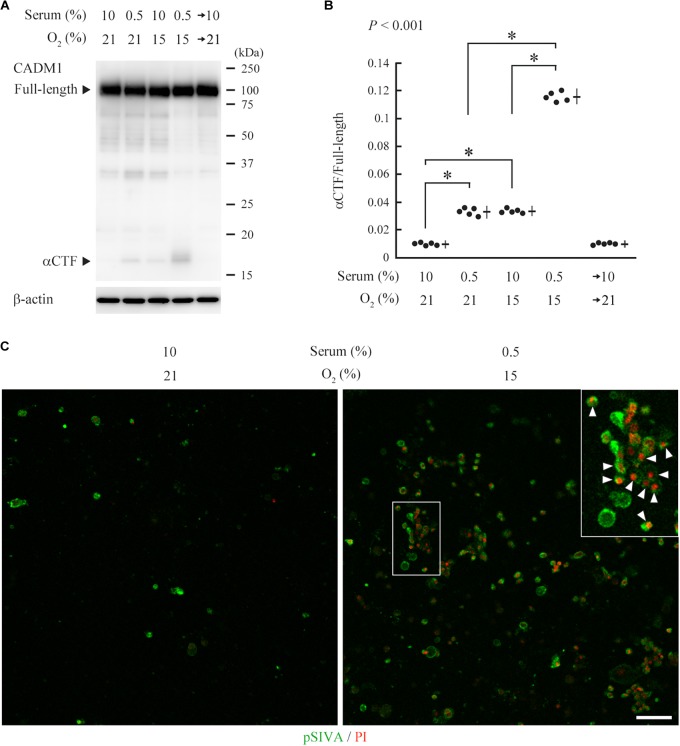
Induction of urinary cell adhesion molecule 1 (CADM1) ectodomain shedding and apoptosis in CNT renal tubular cells under ischemia-like conditions. (A) CNT cells were cultured for 3 days under normal conditions [10% fetal calf serum and 21% O2] or ischemia-like hypoxic conditions [10% serum and 15% O2, serum-starved (0.5% serum and 21% O2)], or both (0.5% serum and 15% O2). The combined condition was restored to normal, and the cell culture was continued for another 2 days (serum→10% and O2→21%). Cell lysates were analyzed by Western blotting with anti-CADM1 C-terminus antibody (upper panel). The blot was reprobed with an anti-β-actin antibody to indicate the amount of protein loading per lane (lower panel). Representative results are shown. (B) Expression levels were densitometrically measured from five independent experiments and were plotted. The mean ratios of αCTF/full-length CADM1 and the SDs are depicted as cross lines. P-value using one-way ANOVA is shown, and the Bonferroni correction was applied to particular two groups: ∗P < 0.01. (C) CNT cells were cultured for 3 days under normal or ischemia-like conditions as indicated, and were then labeled with pSIVA (green) and propidium iodide (PI; red). A boxed area is enlarged in the inset. Arrowheads indicate pSIVA and PI double-positive cells. Bar = 50 μm.